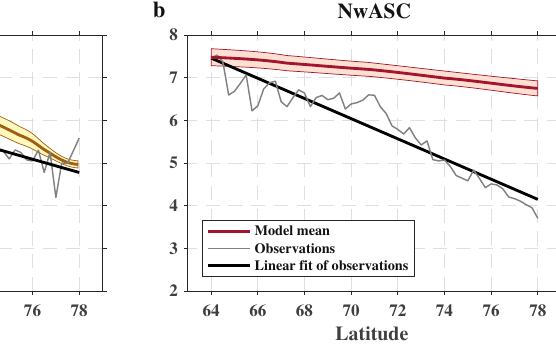
Fig. 3 | Contribution of air – sea heat fl ux to the cooling of the Atlantic Water layer.a NorwegianAtlanticFrontCurrent(NwAFC)and b NorwegianAtlanticSlope Current (NwASC). The Atlantic Water layer is taken to be 0 – 550m. The simulated temperaturechange (ensemblemeanofmonthlyPrice – Weller – Pinkelmodel runs) of Atlantic Water along the NwAFC and NwASC are shown in yellow and red,